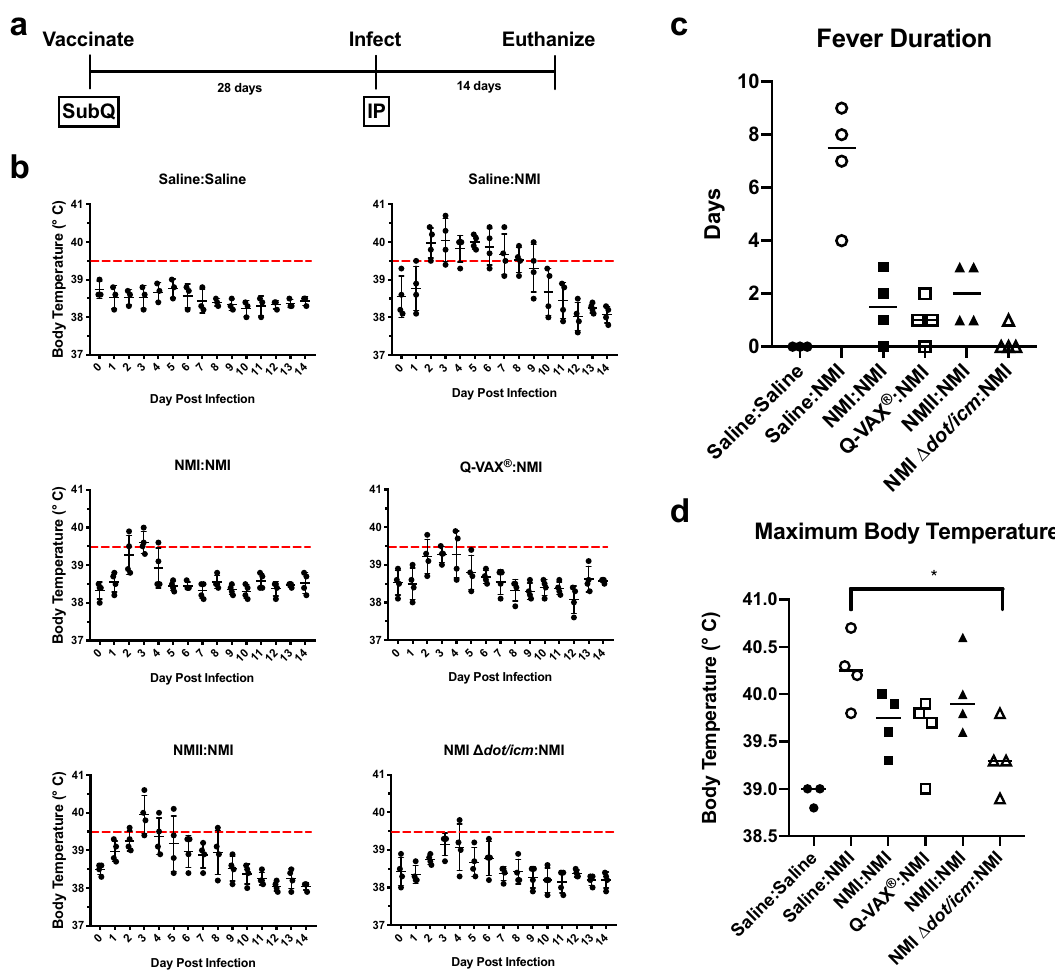
Fig. 5 NMI Δ dot/icm WCV protects against C. burnetii challenge. a Guinea pigs were subcutaneously vaccinated with 25 μ g of C. burnetii WCV or Q-VAX ® , or mock infected with saline, then allowed to rest for 28 days. Animals were then intraperitoneally infected with 10 6 GE NMI or mock infected with saline, monitored for 14 days, and euthanized. b Body temperatures were recorded daily from the day of infection (day 0) until the day of euthanasia (day 14). Temperatures were plotted for each animal per time point throughout the duration of infection. Fever was de fi ned as ≥ 39.5 °C and is indicated by the dotted line. Fever duration c and maximum body temperature d are presented for each animal. These two endpoints were evaluated based on differences in group means (horizontal bar) with associated con fi dence intervals. For each reported comparison, p -values were computed at the α = 0.05 level for two-sided two-sample t tests, allowing for unequal variances between groups. No adjustment was made for multiple comparisons due to the sample sizes ( n = 4 except for Saline:Saline with n = 3) and the descriptive nature of the study. * p ≤ Visualization of C. burnetii LPS and bacterial enumeration Guinea pigs C. burnetii LPS was extracted by modi fi ed hot phenol extraction and Table 3 Hartley guinea pigs were obtained from Charles River (strain code visualized by silver stain and immunoblot 30,43 . All samples utilized in silver 051) at 4 to 6 weeks of age. Animals were acclimated for at least a week stains and immunoblots were derived from the indicated experiments and prior to experimental manipulation. In light of historical Q fever virulence were run in parallel. Uncropped gel and blot images are presented in studies 29,74 , and to minimize potentially confounding sex-associated factors (e.g., behavior, body weight, hormonal effects), female guinea pigs Supplementary Figs. 9 and 10, respectively. The BioRad Precision Plus were utilized in these studies. Animals were housed in individually Protein Dual Color Standard was utilized as a molecular weight marker in these experiments. C. burnetii stocks used for infection were quanti fi ed using qPCR to enumerate genome equivalents (GE) 43 . Fixed C. burnetii used in WCVs were enumerated using a direct bacterial count as modi fi ed from Ormsbee et al. 73 . Bacteria were stained with Hoechst dye for 20 min, washed in PBS, then sonicated for 5 min in a bath sonicator (60 sonics/min) to eliminate clumping. Dilutions of bacterial suspensions were imaged on glass slides in triplicate using a Nikkon Eclipse T2 microscope. Bacteria were delinated in micrographs using Cell Pro fi ler ™ software and enumerated based on the following conversion factors: average particle count per fi eld × 1705 (# of fi elds per view) × dilution factor. For WCV dose approximation, bacterial numbers were converted to mg dosages using the puri fi ed dry weight calculations of Ormsbee et al. 73 (3.78 × 10 10 C. burnetii per mg). 2018-002-E). Animal experiments and procedures were performed in an